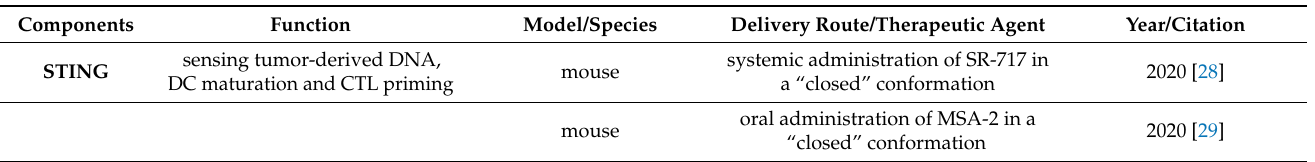
Table 1. Induction and delivery of innate immune components synergizing with immunotherapy: summary of recent preclinical and clinical studies.